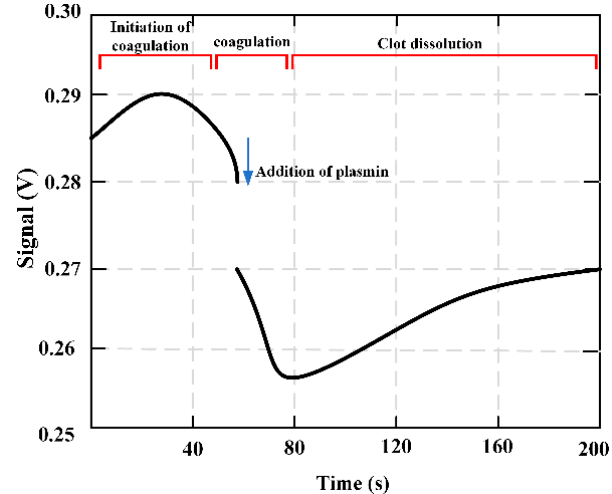
Figure 16. A graphical representation of the output signal obtained during the process of coagulation monitoring.